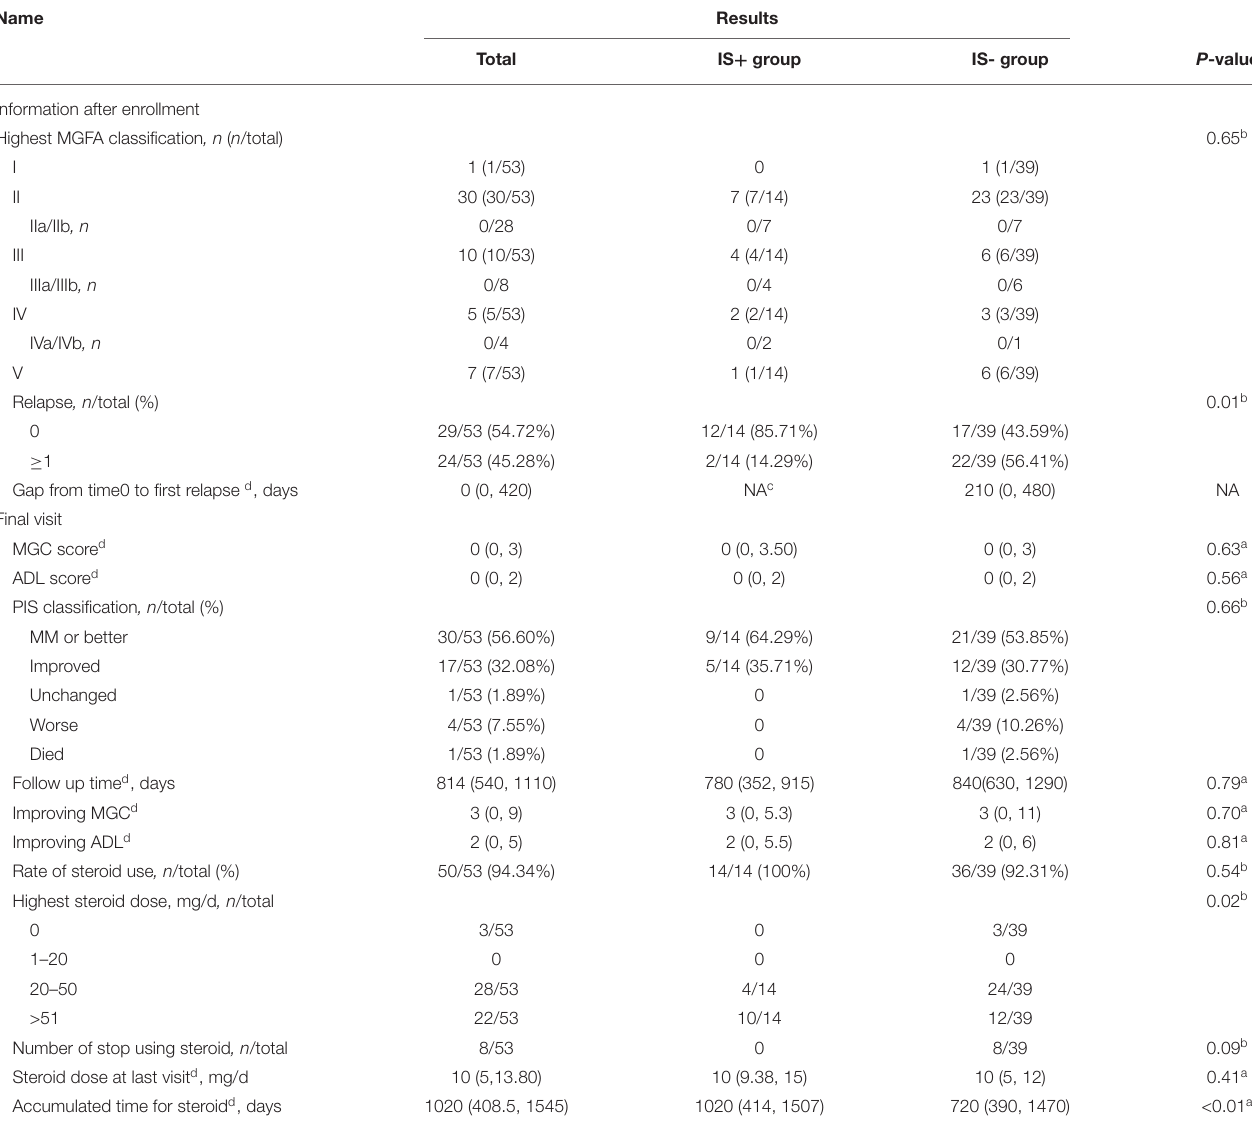
TABLE 1B | Follow up outcomes of